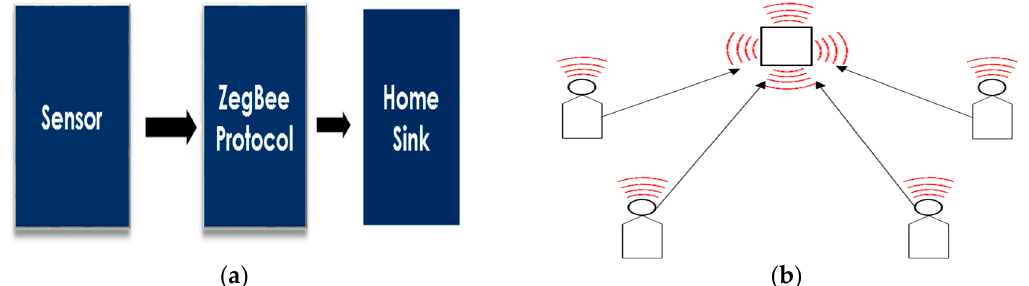
Figure 6. ( a ) Flow diagram of the Wireless Sensor Node ( b ) Star topology.